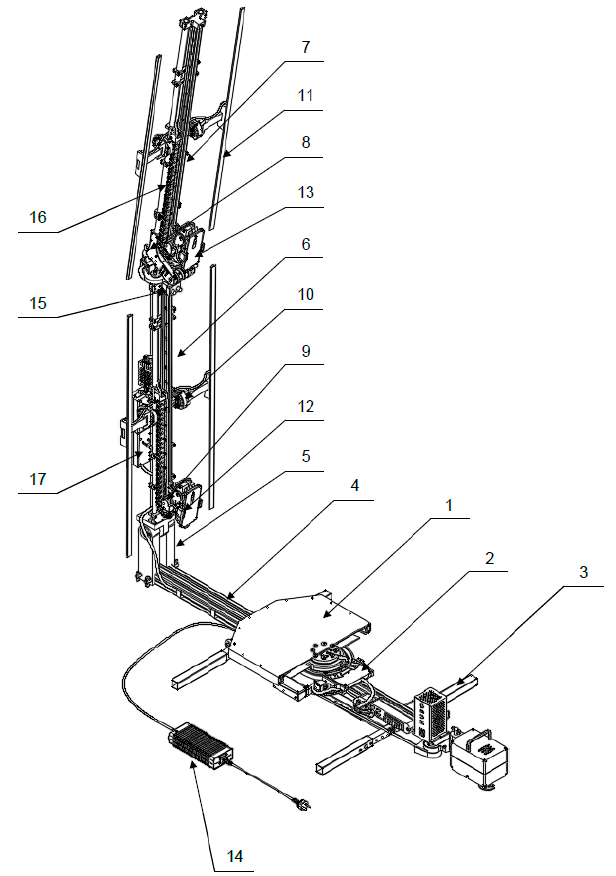
Figure 3. Illustration of the detailed design of the HUBO scanner.